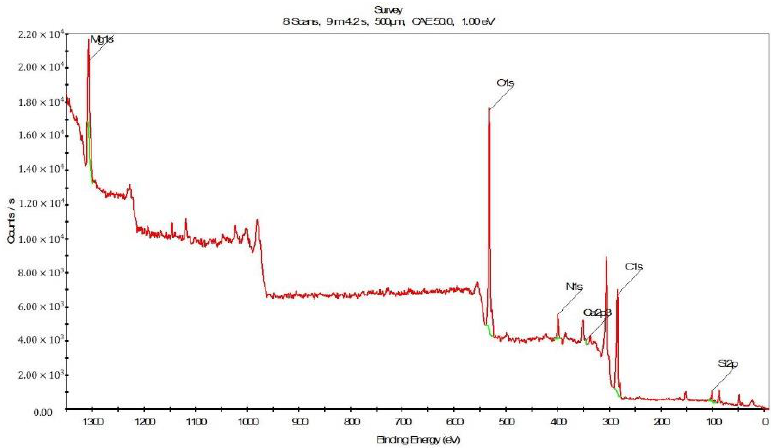
Figure 14. The XPS spectra of the deposits in the spacer.